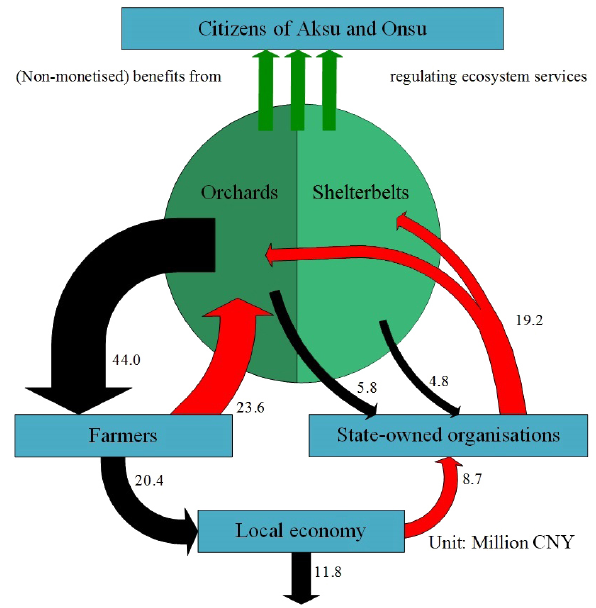
Figure 5. Graphic summary of the cost and benefit flow of Kökyar I (red arrows representing costs, black arrows monetary